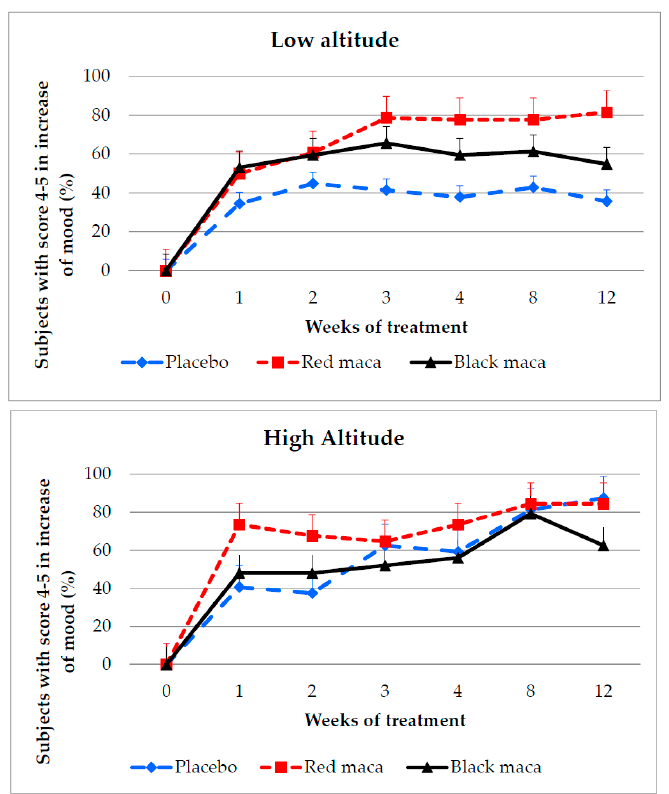
improved mood was higher after treatment with red maca than with black maca ( p = 0.0005) but no different with respect to the placebo (Figure 2, bottom). Effect size between placebo and red maca placebo (Figure 2, bottom). Effect size between placebo and red maca was d = 0.68. Between placebo was d = 0.68. Between placebo and black maca it was d = 0.25 and between red and black maca it was and black maca it was d = 0.25 and between red and black maca it was d = 0.43. d = 0.43. At weeks 8 and 12 at LA and at HA, red maca increased mood in around 80% of subjects.